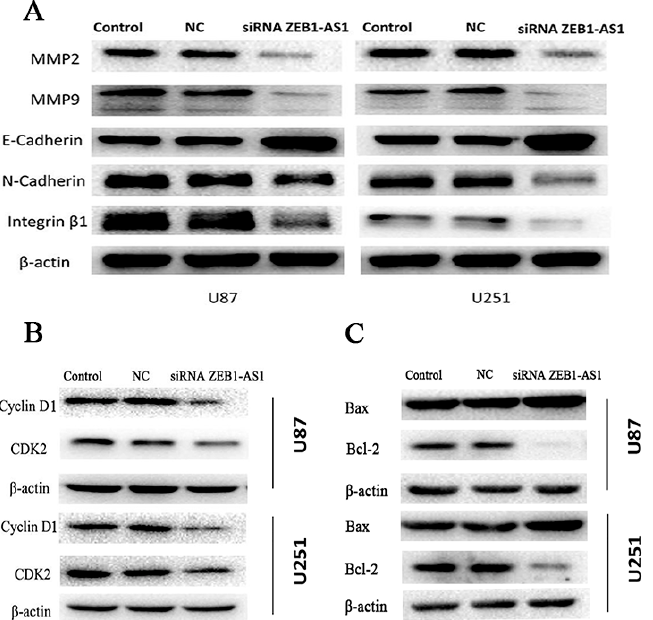
Figure 6. Protein levels of cell cycle, EMT, and apoptosis markers after lncRNA ZEB1-AS1 knockdown. ( A – C ) The expression of Cyclin D1, CDK2, MMP2, MMP9, N-cadherin, Integrin- β 1, and